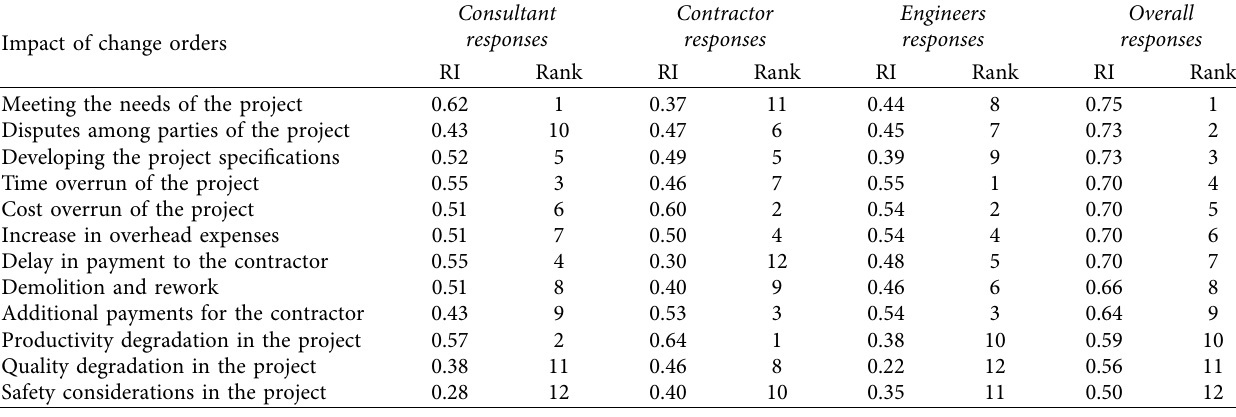
Table 6: Frequency of impact of change orders on